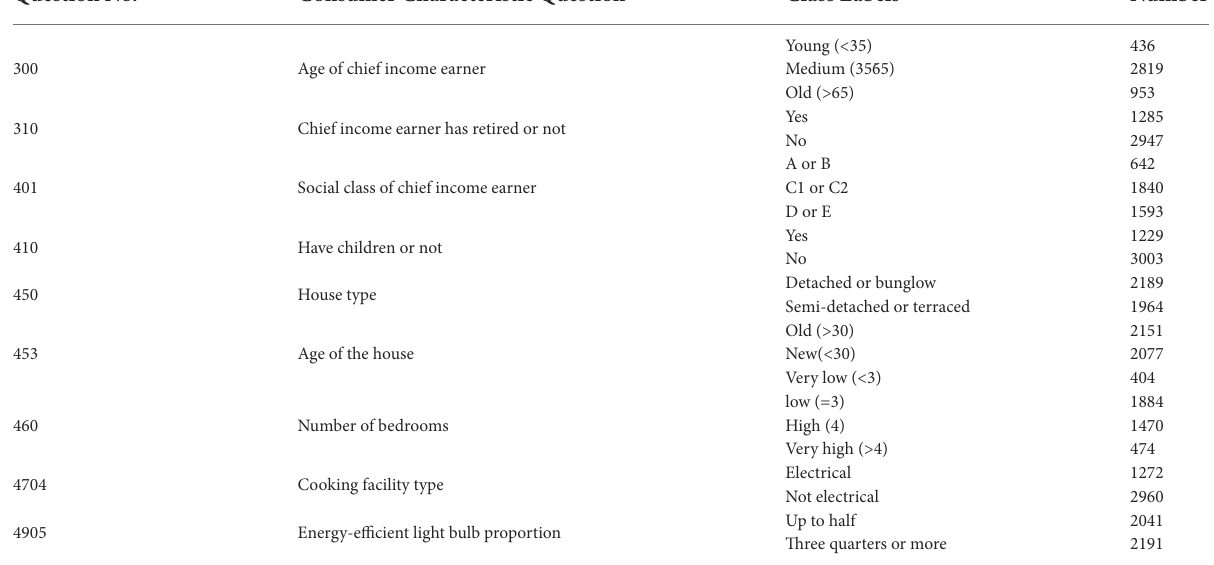
TABLE 2 Thecharacteristicstobestudied.